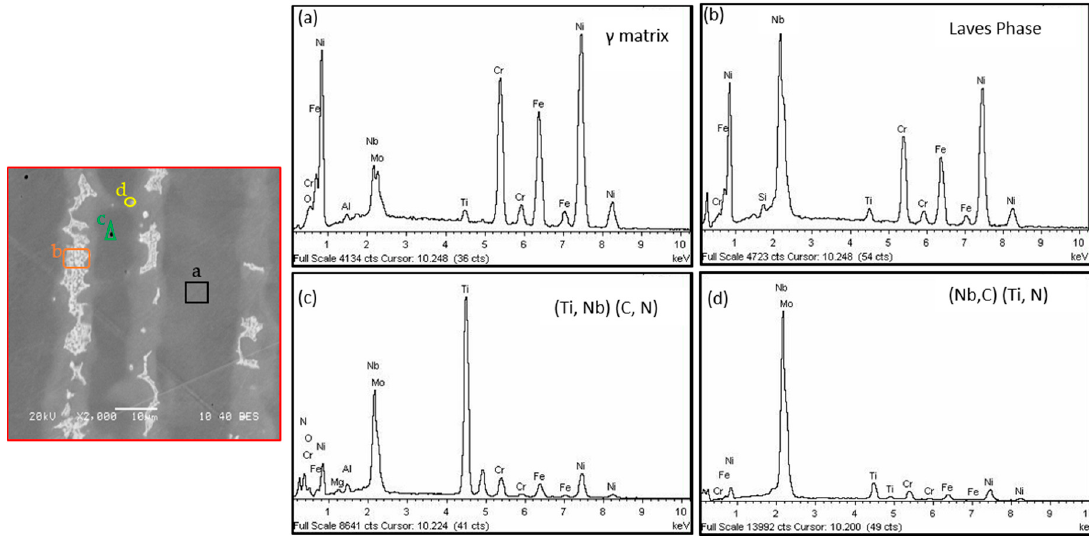
Figure 11. Energy-dispersive X-ray spectroscopy (EDS) image (on the left) and EDS spectrums (on the right) taken from major phases that appear in the as-deposited microstructure of WAAM IN718 alloy ( a ) Υ solid solution matrix; ( b ) Laves phase particle ( c ) Titanium carbides and ( d ) Niobium carbides.